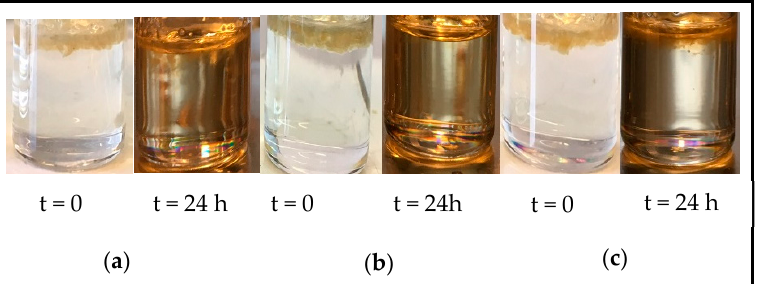
Figure 6. Solubility of FGSB1 ( a ), FGSB1A50 ( b ), and FGSB1A120 ( c ) in dichlorobenzene at 120 °C for 24 h.